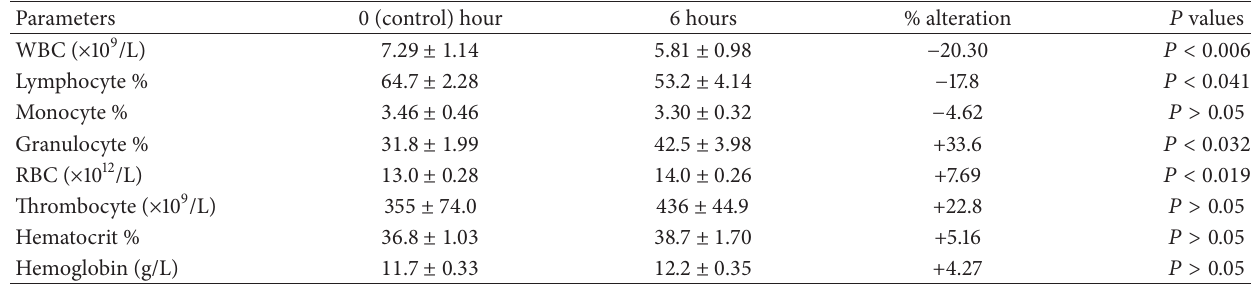
Table 3: The effect of diclofenac (2.5mg/kg, IM) on hemogram parameters in rams (mean ±